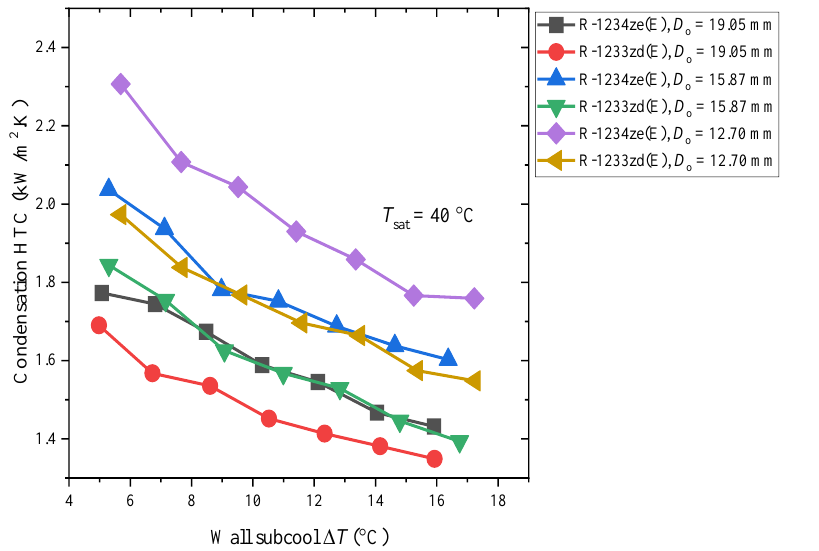
Figure 2. Influence of tube diameter (smooth tube) on condensation HTC (Ko et al. [8]). The comparative condensing heat transfer performance of low-GWP refrigerants R- 1234yf, R-1234ze(E), R-1234ze(Z), and R-1233zd(E) as alternatives to R-134a is depicted in Figure 3. Ko and Jeon’s [9] studies exhibited that the average film condensation HTC of R-1233zd(E) and R-1234ze(E) was 10.04% and 10.97% lower as compared to R-134a, respectively. For R-134a and R-1234ze(E), a similar condensation HTC was also shown by Nagata et al. [12]. However, for the R-1233zd(E) and R-1234ze(Z), the condensation HTCs of Nagata et al.’s [12] results are quite contradictory when compared to Ko and Jeon [9], and even their own results, because R-1233zd(E) and R-1234ze(Z) showed higher condensation HTCs than R-1234ze(E) and R-134a, respectively. According to Park et al. [11], whose experimental test results are shown in Figure 3, the condensation HTCs of R-1234yf were remarkably similar to those of R-134a. Moreover, Ko and Jeon [9] investigated the film condensation HTCs of R-134a, R-1234ze(E), and R-1233zd(E) on three types of enhanced tubes, namely E1, E2, and E3. E1 and E2 have the same fins per inch (FPI) of 55 with knurling numbers 85 and 107, respectively, while E3 has 60 FPI with knurling number 117. Figure 4 indicates that the tube with the highest FPI and knurling number (E3) showed the highest condensation HTC for all refrigerants, and the condensation HTC decreased with increasing wall subcool temperature/heat flux. The authors of [9] observed that the FPI number had a greater influence on the condensation HTC than the knurling number. However, R-134a displayed the highest film condensation HTCs for all the enhanced tubes, while R-1233zd(E) displayed the lowest HTC. In particular, for E1, the average condensing HTCs of R-1234ze(E) and R-1233zd(E) were 1.87% and 27.44% lower than that of R-134a. For E2, the average condensation HTCs of R-1234ze(E) and R-1233zd(E) were 4.67% and 27.76% lower than that of R-134a. For E3, the average condensation HTCs of R-1234ze(E) and R-1233zd(E) were 11.83% and 41.18% lower than that of R-134a. Therefore, these findings suggest that when the condensing surface area increases, the decrease in film condensation HTC increases for each refrigerant. Ji et al. [10] investigated the influence of fin thicknesses on the film-wise condensation HTC of R-134a, R-1234ze(E), and R-1233zd(E) outside the finned tubes. The tubes T- C1 and T-C2 have the same fin density and similar fin height while the fin thickness is different. Figure 5 shows that a tube having a thicker fin thickness has comparatively higher HTCs than a thinner-fin-thickness tube. For R-134a, the condensing HTC of T-C2 was 0.8 to 4.1%, 11.9 to 13.8%, and 10.3 to 19.7% higher than T-C1 for R-134a, R-1234ze(E), and R-1233zd(E), respectively. Moreover, in terms of low-GWP-refrigerant performances, the condensing HTC of R-134a was nearly 2 times higher than R-1233zd(E) and 10